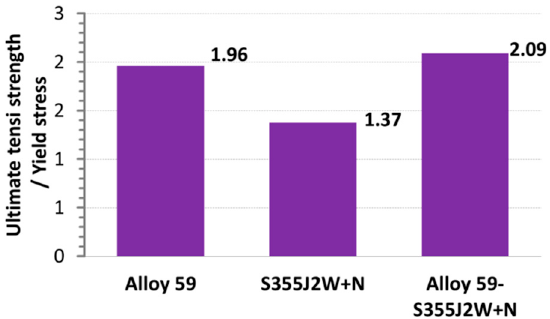
Figure 16. Proportion between ultimate tensile strength and yield stress of the base metals (Alloy 59, S355J2W+N) and the mixed joined. Values of the mechanical parameters are directly taken from Figures 13–16.